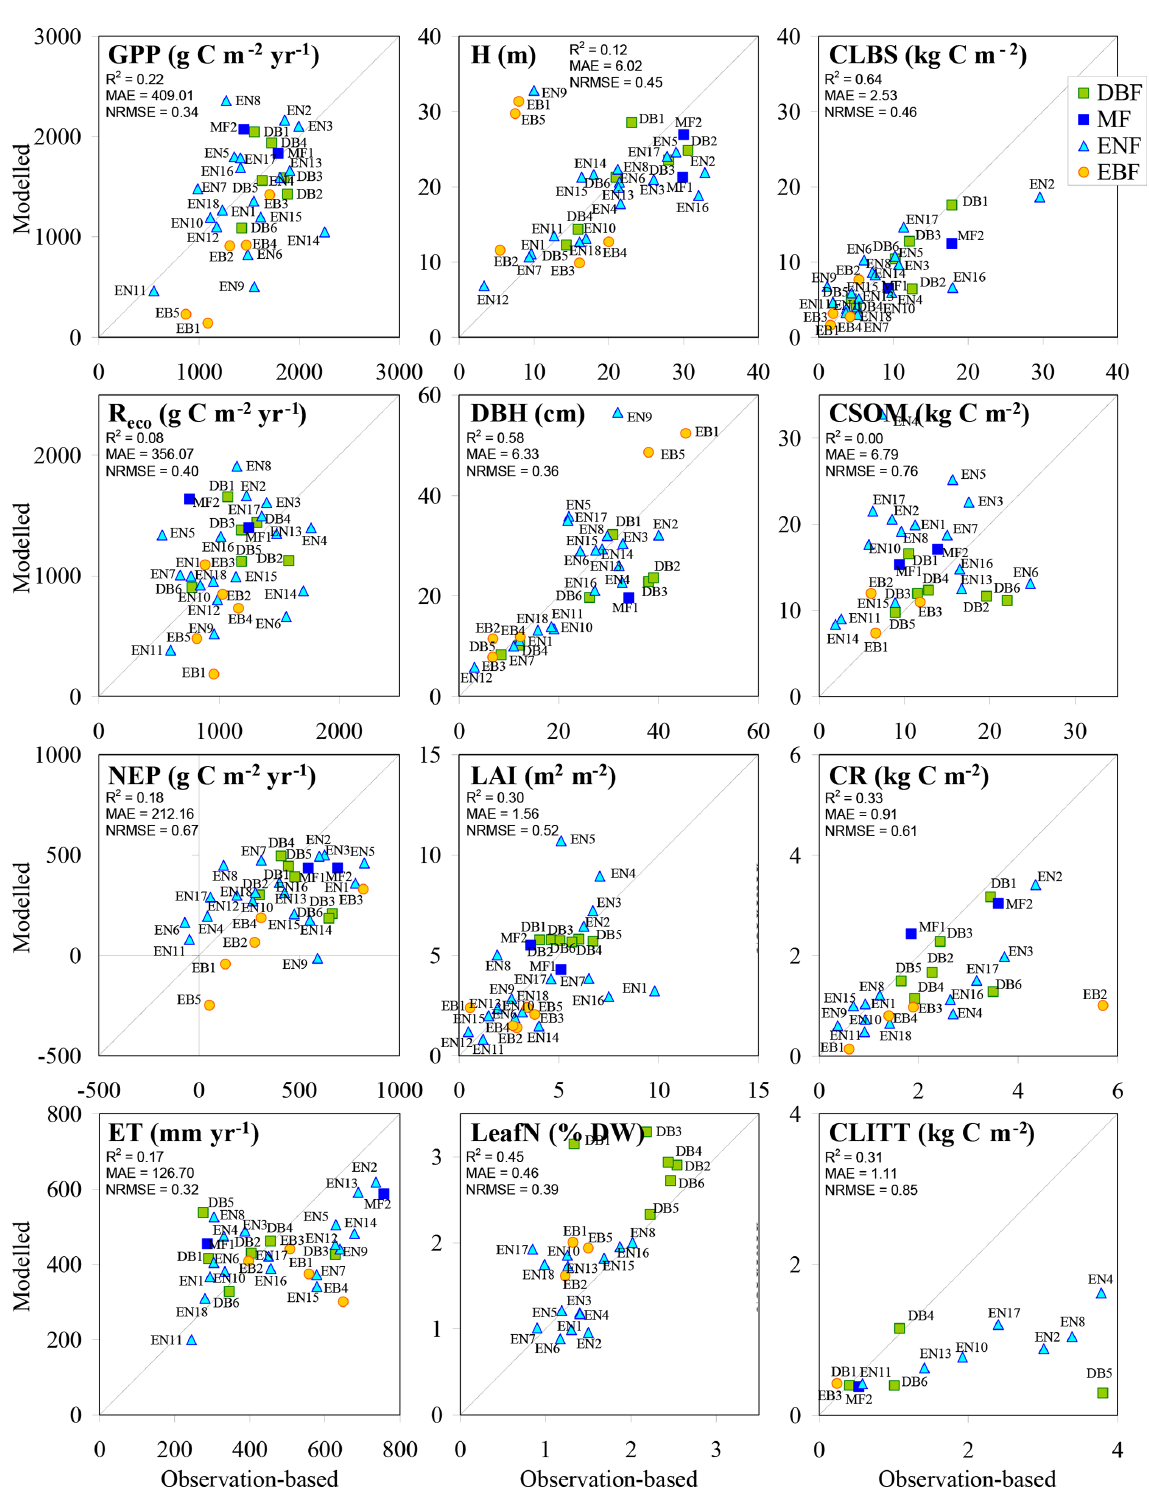
Figure 6. BASFOR baseline simulations for all forest sites; model outputs and observation-based values were averaged over the years between the first and last available observations. Note that model simulations include MF and EBF sites, for which the model was not calibrated in Cameron et al. (2018); the two MF runs were made using the parameter table for DBF, while the five EBF runs were made using the parameter table for ENF to allow continued growth throughout the year. H: mean tree height; DBH: mean diameter at breast height; CLBS, CSOM, CR, CLITT: carbon stocks in leaves, branches and stems; in soil organic matter; in roots; and in litter layers, respectively; R 2 : coefficient of determination; MAE: mean absolute error; NRMSE: root mean square error normalized to the